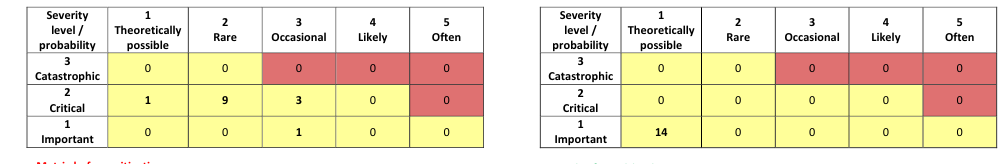
Figure 3. Results of the risk management process in the Corona Health